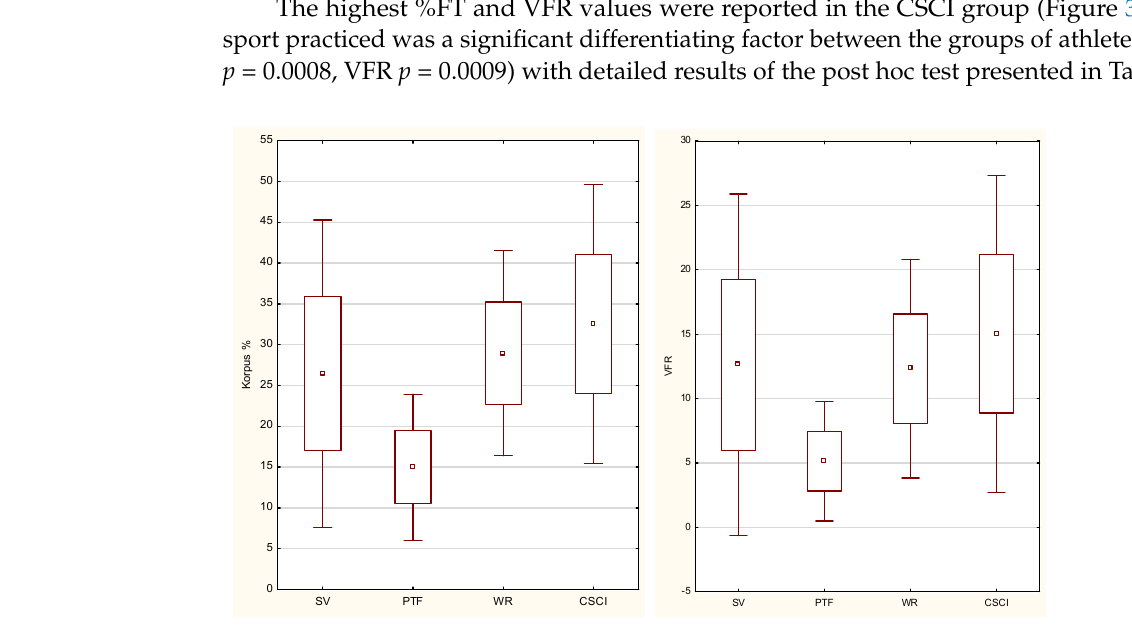
Figure 3. Distribution of body fat percentage (%FT) and viscera fat rating (VFR) in the study groups (SV—sitting volleyball players; PTF—Para track and field athletes; WR—wheelchair rugby player; CSCI—cervical spinal cord injury). Table 4. Post hoc test for multiple comparisons of body composition.